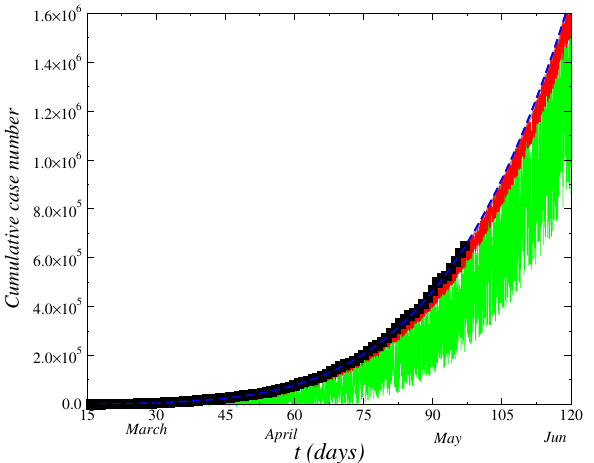
Figure 1. Effect of the stochastic term on cumulative total case number of COVID-19, P ( t ) , in Brazil. We perform the calculations for different values of strength of randomness β 0 in model Eq. (1): β 0 6 3.0 10 blue-line), β 0 (red-line) and β 0 − = ×